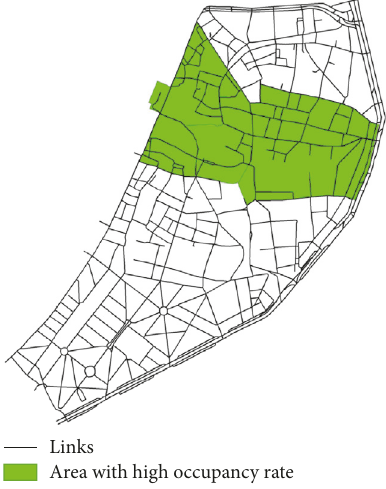
Figure 7: Part of the simulation area with a high occupancy rate throughout the simulation